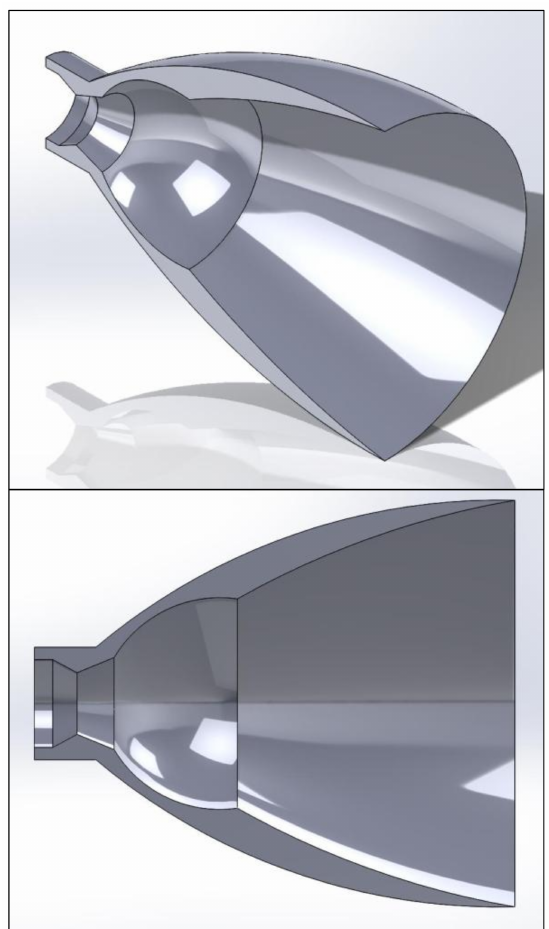
Figure 29. Cross-sectional view of nozzle: isometric ( top ) and side ( bottom )